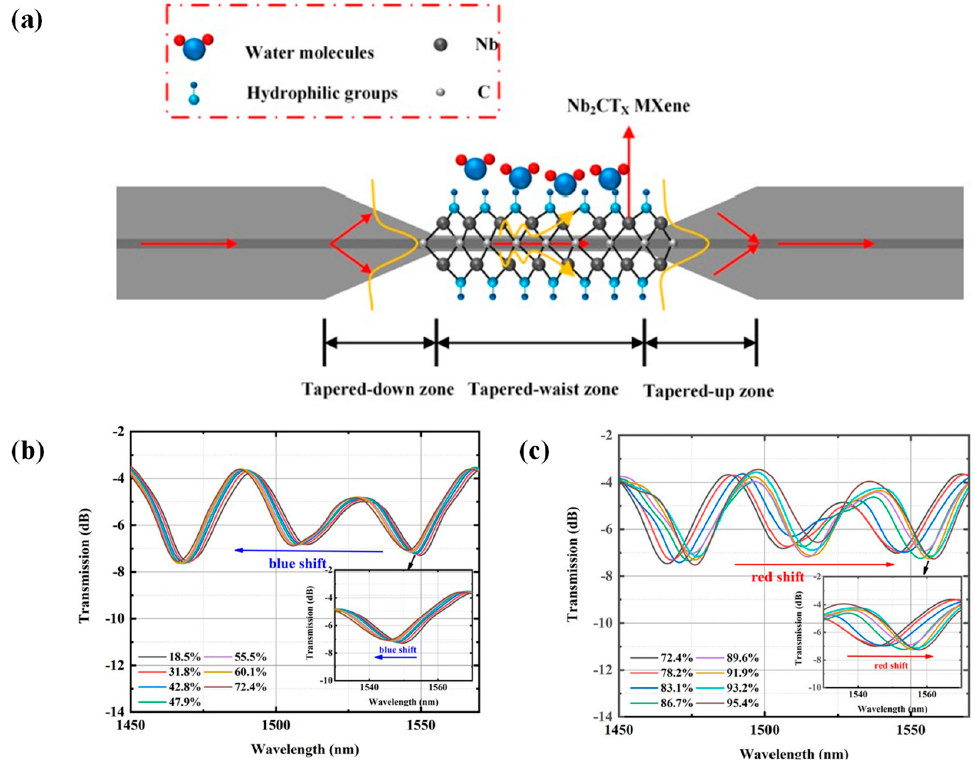
Figure 13. Applications of Nb 2 CT x in sensors. ( a ) Schematic diagram of the Nb 2 CT x nanosheet-coated microfiber RH sensor, ( b ) Transmission spectra in the RH range of 18.5–72.4% RH, ( c ) Transmission spectra in the RH range of 72.4–95.4% RH. [18] Copyright American Institute of Physics, 2022.